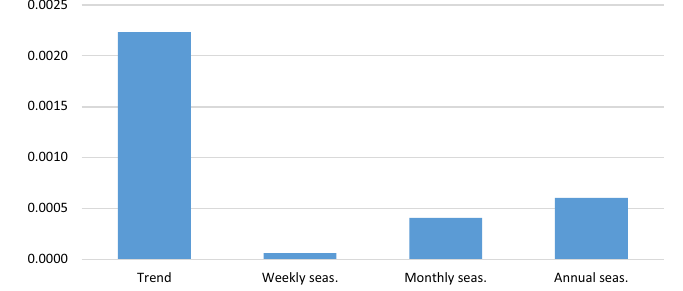
Fig. 3 Transmissionofaninnovationtothecomponents. Note Theunitsarefractionsofthestandarddeviation of the innovation